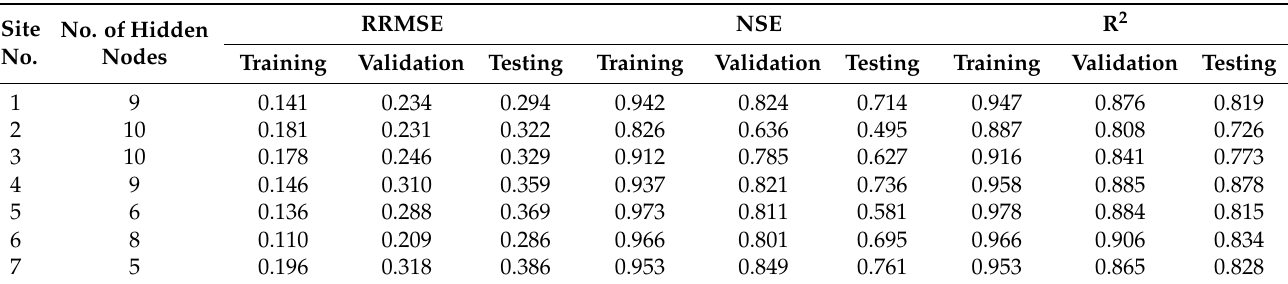
Table 4. Performance statistics of the optimal